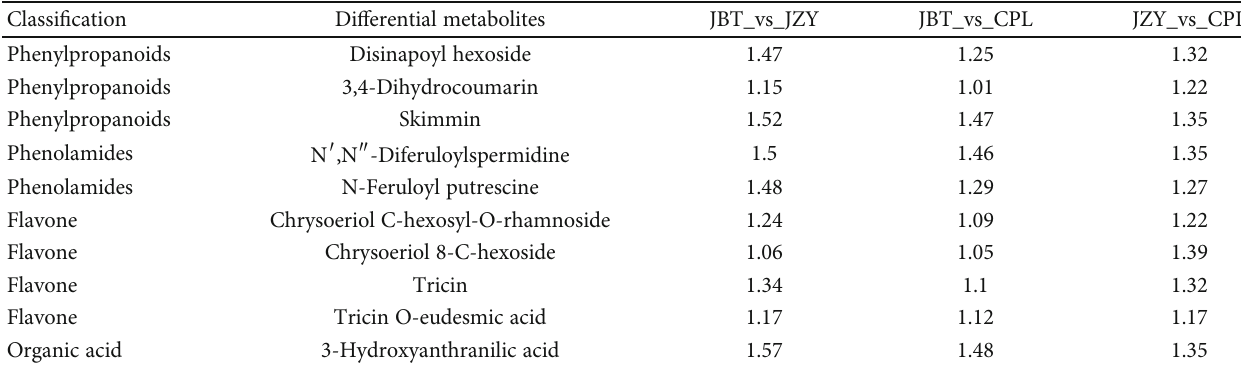
Table 1: VIP values for the ten di ff erential metabolites in sweet corn